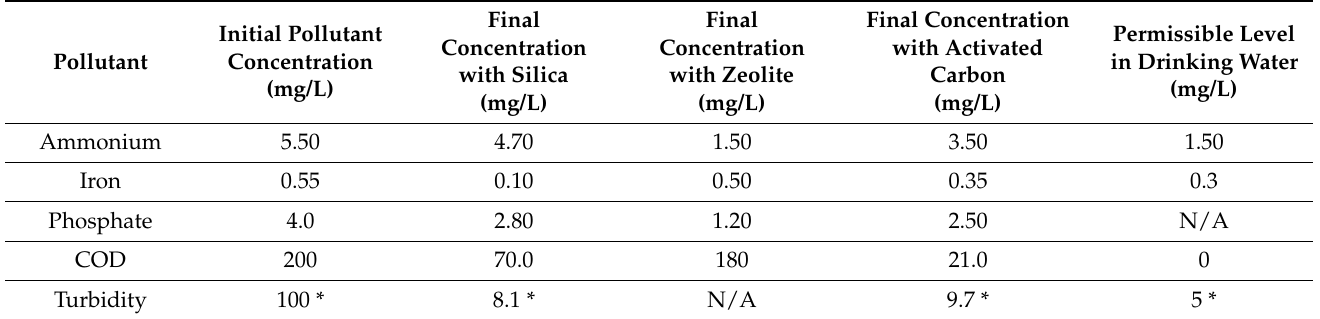
Table 13. The concentration of pollutants before and after adsorption of silica, zeolite and activated carbon [75].